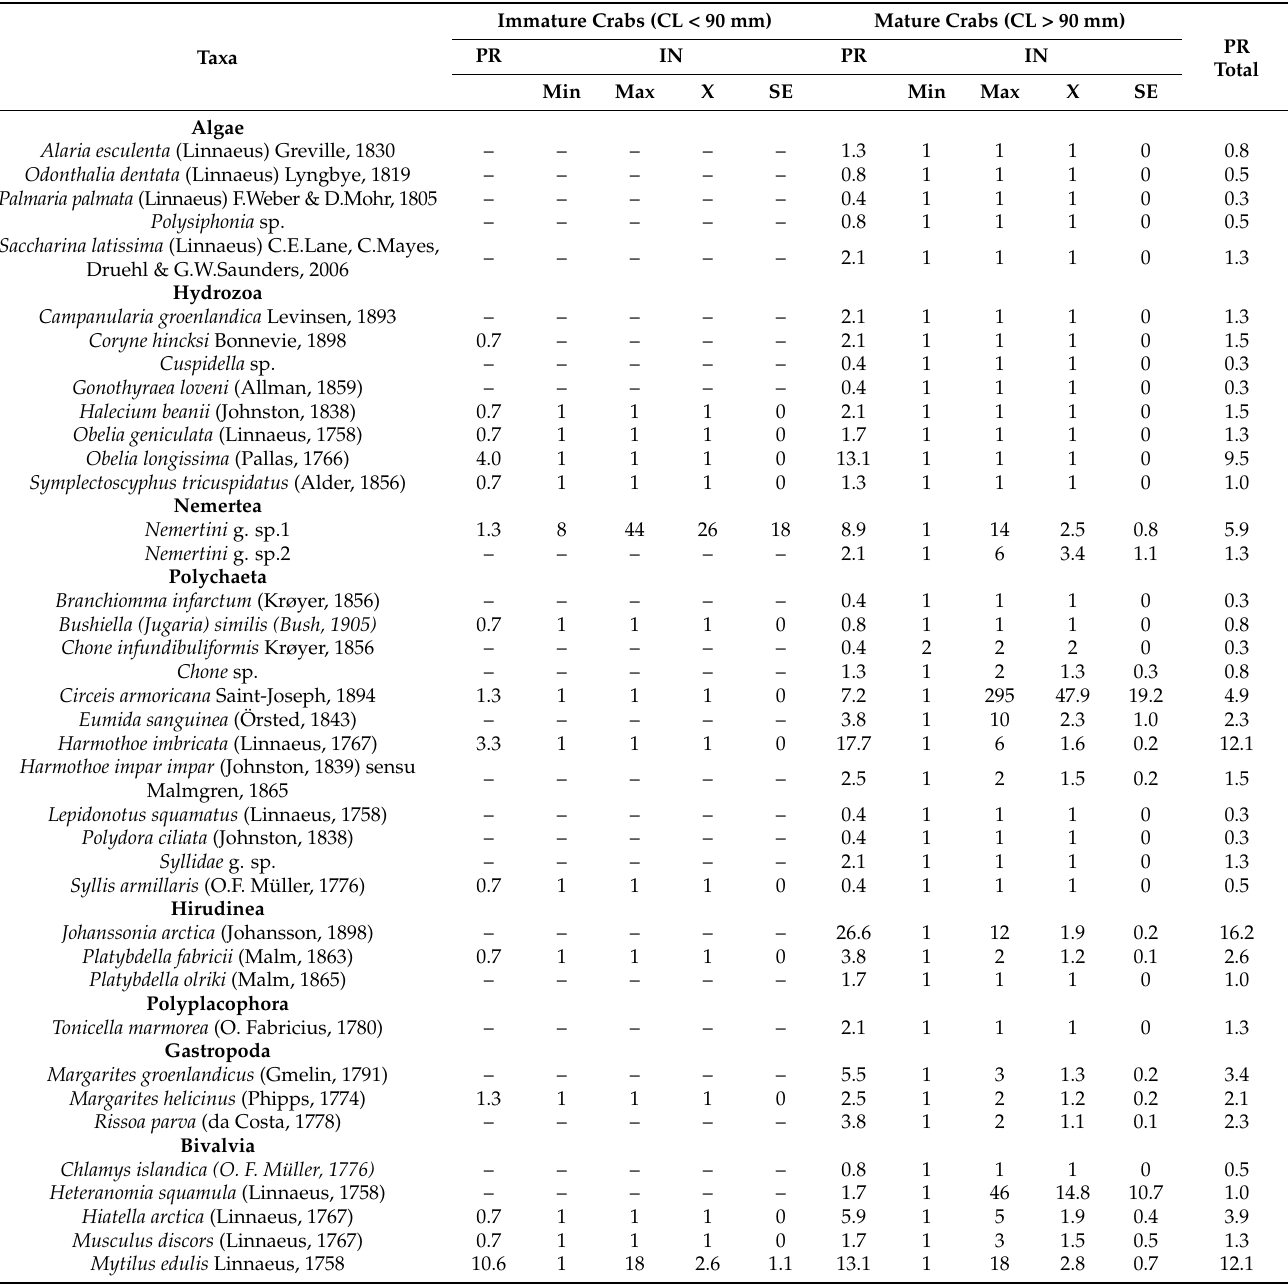
Table 1. List of taxa found on immature and mature red king crabs and their indices of infestation (prevalence (PR), %; intensity (IN), individuals per crab) in Dalnezelenetskaya Bay in summers during the period